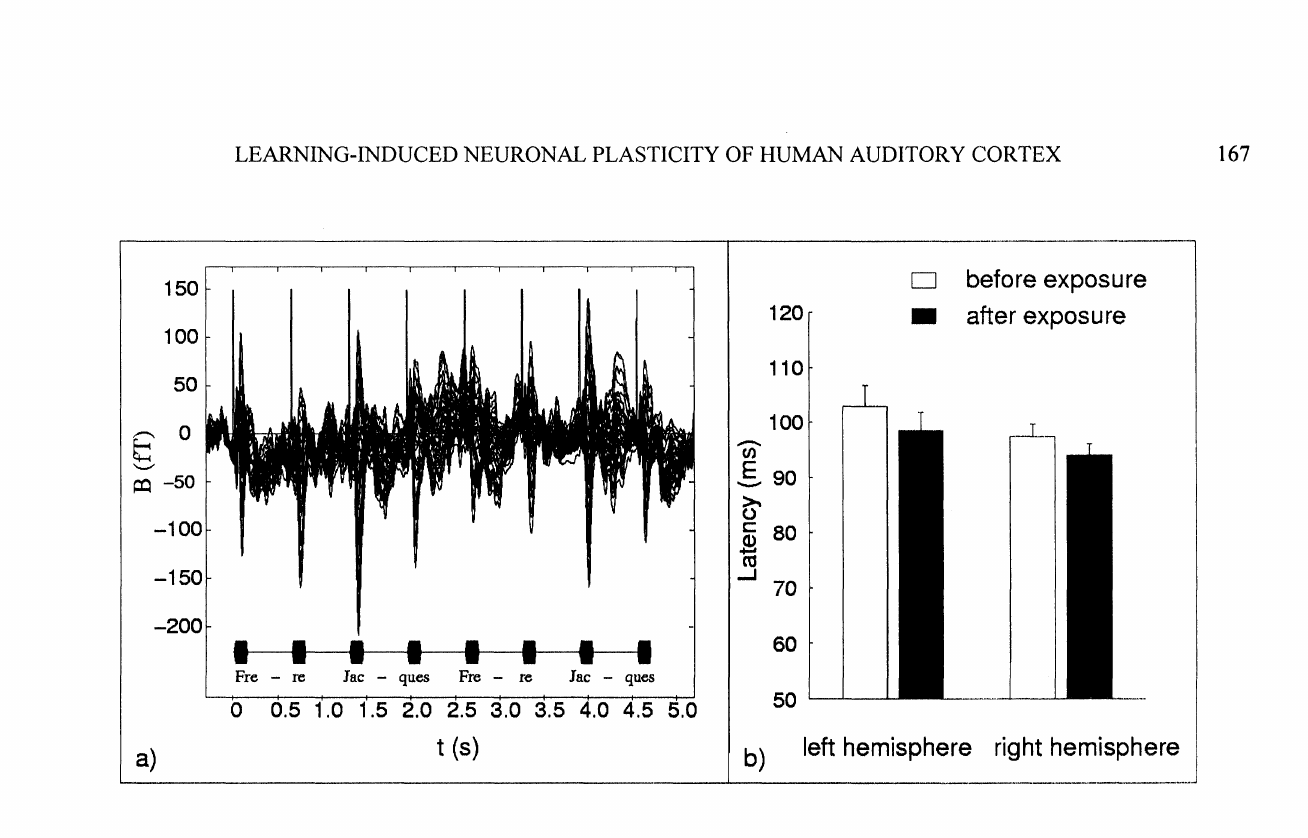
Fig. 2: (a) Averaged Nlm-responses of one individual subject to the eight tone-sequences (magnetic fields in fT, low pass filtering: 0-20Hz). Waveforms, as derived from the 37 gradiometer channels, are shown together with the trigger signal (regular vertical lines). The inset denotes the onset and the duration of the stimuli, b) Mean values and standard errors of the mean (s.e.m.) of the latencies corresponding to the RMS maxima of wave N lm. Black bars show the values after and white bars before exposure. Error bars illustrate the